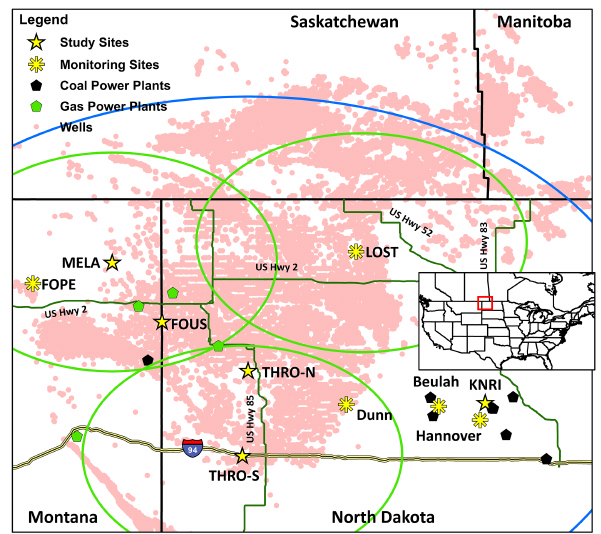
Figure 1. Map of study area, including state monitoring sites and regional power plants. For oil and gas wells, shapefiles were filtered to only include active and/or producing wells. For reference, the blue line represents 250km from THRO-N, the distance traveled by an airmass in 48h, based on the median wind speed at the site dur- ing the study. Green lines represent 100km distance from THRO-S, LOST, and